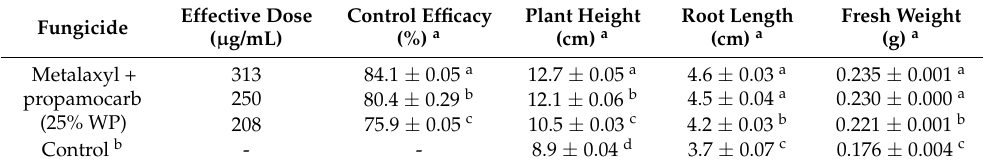
Table 4. Control effect of metalaxyl + propamocarb on rice seedling blight through pot experiment in a greenhouse.